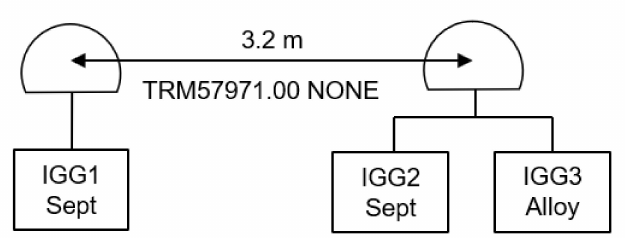
Figure 1. One zero baseline (IGG2–IGG3) and two short baselines (IGG1–IGG2, IGG1–IGG3) using three receivers.